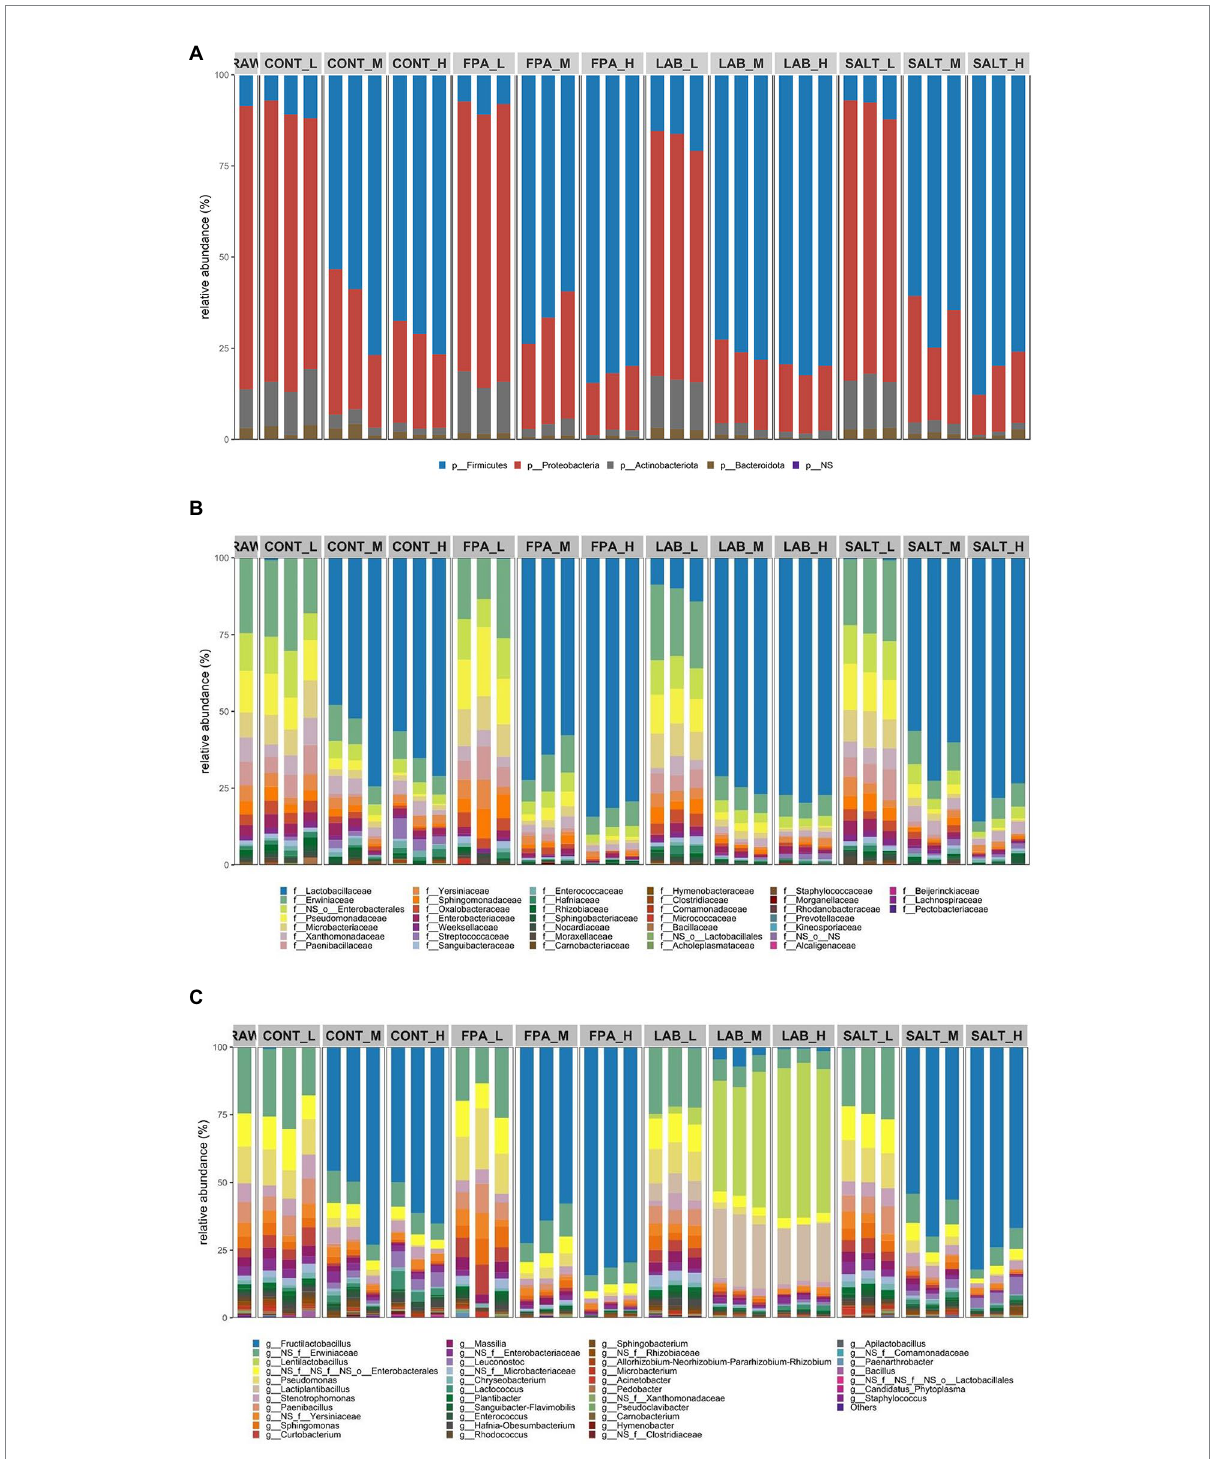
FIGURE 2 Relative abundance of bacterial communities at phylum (A) , family (B) and genus (C) taxonomic levels of crimped barley grain ensiled under different moisture content levels and treated with additives. CONT: control, FPA: formic and propionic acid-based additive, LAB: inoculation with homolactic and heterolactic acid bacteria strains, SALT: salt-based additive, L: low moisture content, M: medium moisture content, H: high moisture content, RAW: raw material prior to